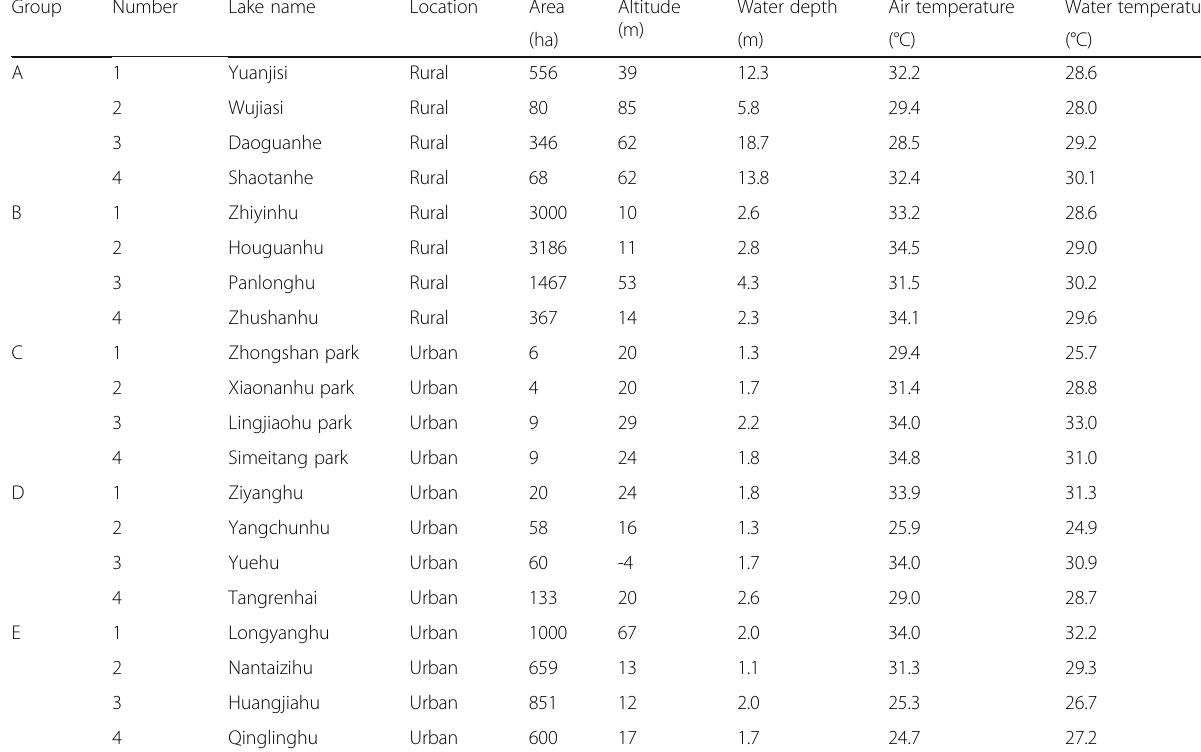
Table 1 Basic information of sampling lakes along a rural to urban gradient in central China Group